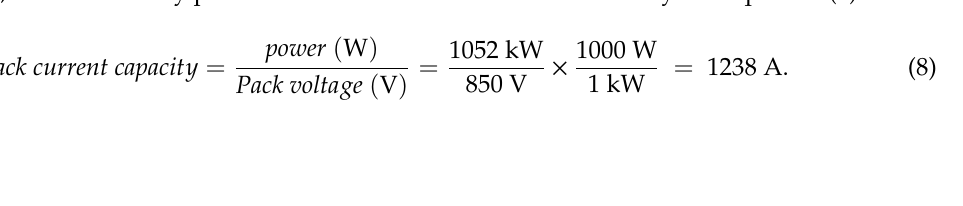
Figure 8. Topology of interest in designing the powertrain for the demanded drive cycle .